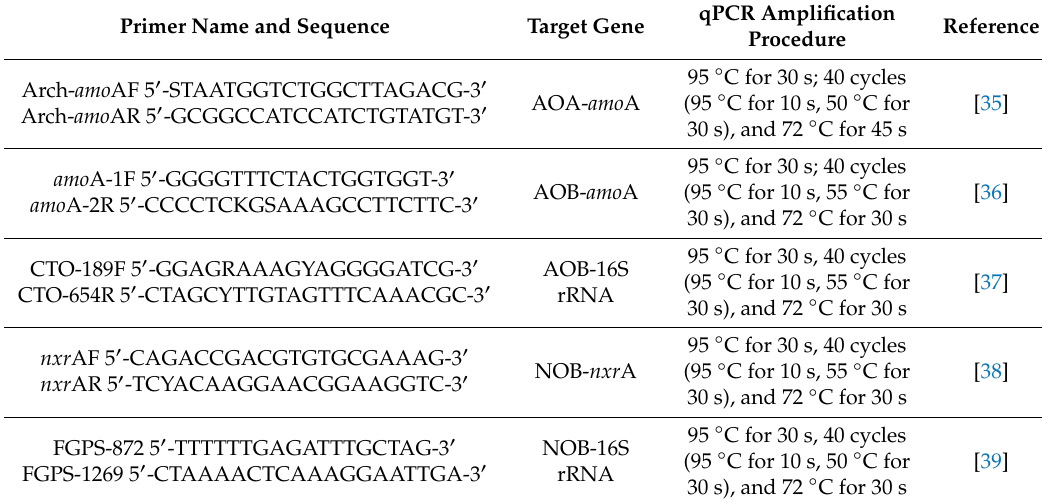
qPCR Amplification Procedure